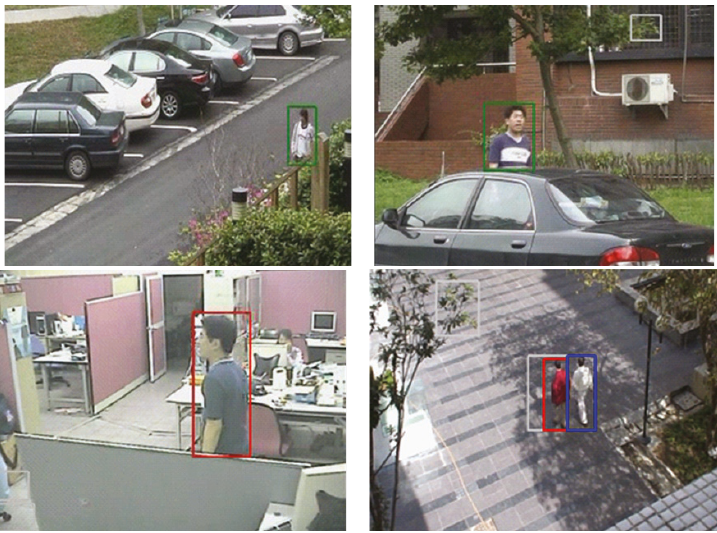
Figure 18: The processed results for some occlusion